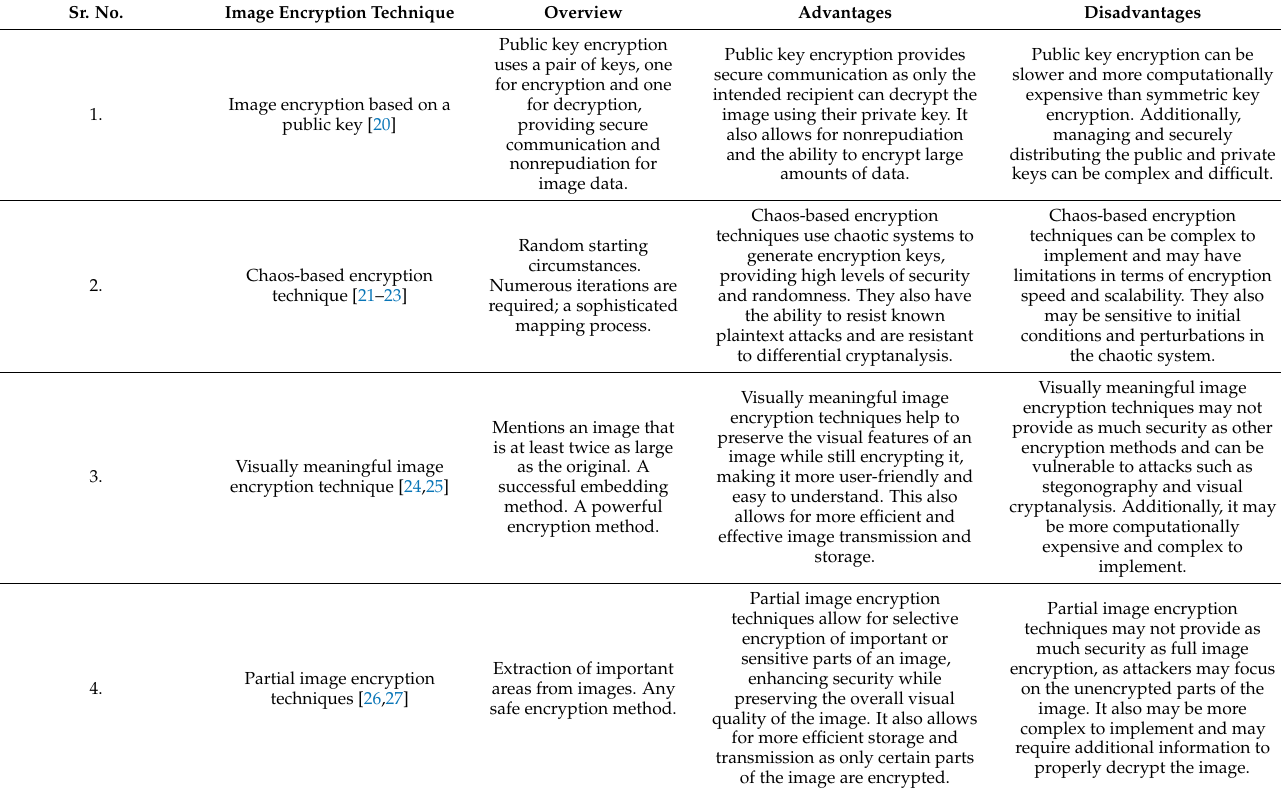
Table 1. Different image encryption